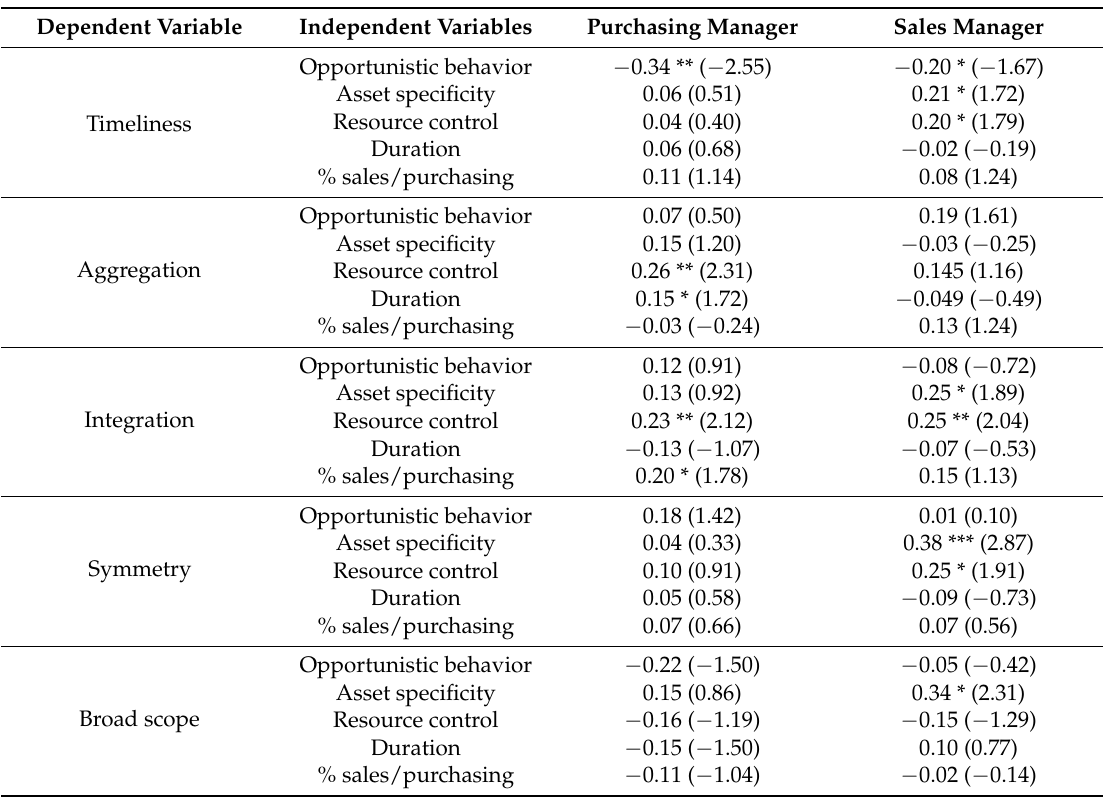
Table 3. Results of the Structural